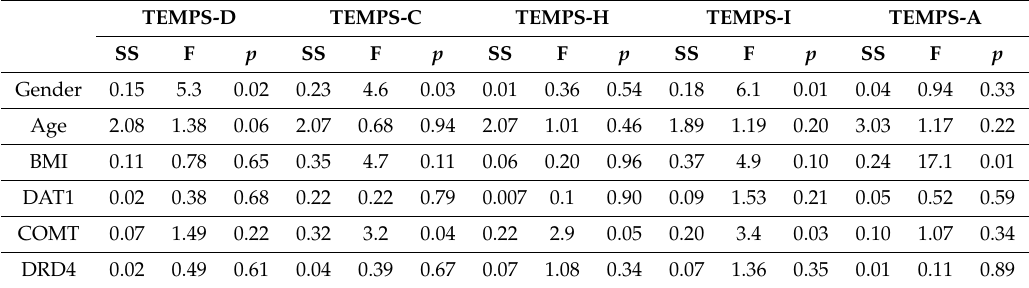
Table 6. Analyses of unidimensional interaction e ff ects for TEMPS-A temperaments subscales. TEMPS-D